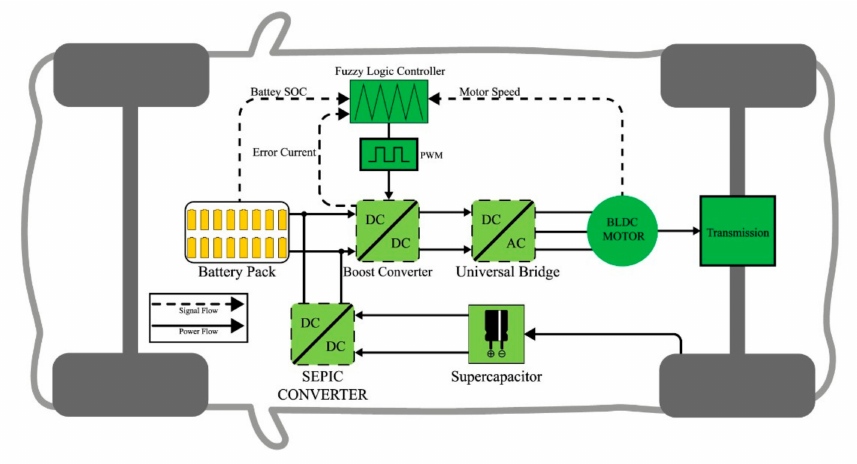
Figure 1. Block diagram of overall proposed